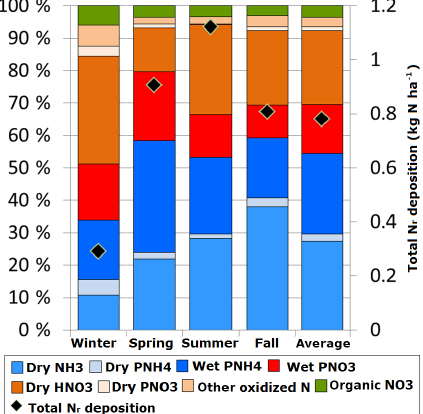
Figure 6. Seasonal CAMx simulated N r deposition budgets aver- aged over the GYA in 2011. The left axis is the relative contribution of different N r species to seasonal N r deposition while the right axis corresponds to the black diamonds for seasonal total N r deposition as an absolute (kgNha − 1